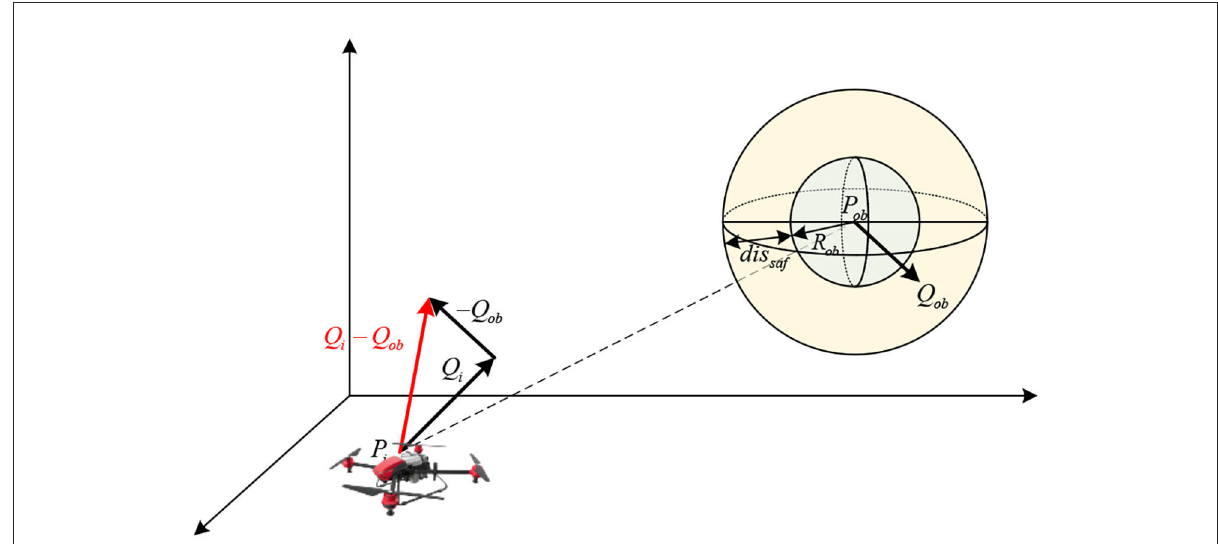
FIGURE2 The collision prediction between i -th UAV and b -th dynamic obstacle.